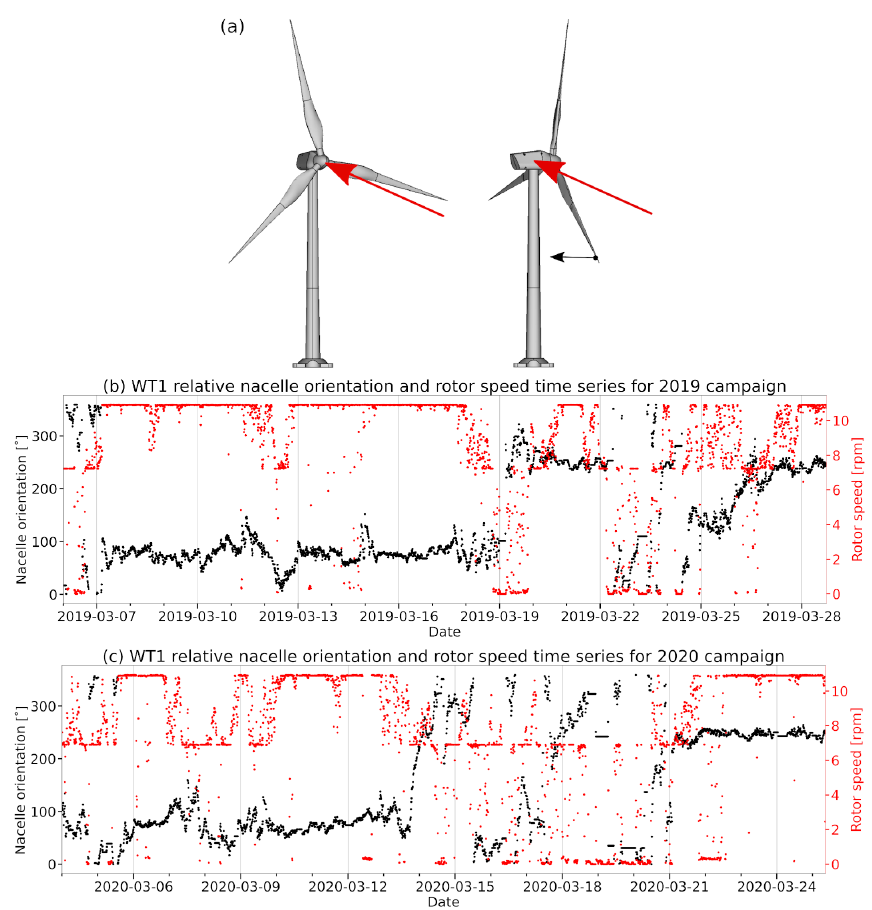
Figure 3. In (a) a schematic view of two wind turbines in relative nacelle positions of 0 ◦ (left) and 270 ◦ (right) with respect to the radar angle of attack (red arrows) is shown. The blade pitch angles are at a high position ( θ > 70 ◦ ), and the direction of blade bending during wind load is indicated by the black arrow. The plots (b) and (c) show the time series of relative orientations (black), with respect to the radar location, of the WT1 nacelle from 6 to 28 March 2019 and from 4 to 25 March 2020. On top and specified by a secondary y axis, the associated rotor speeds are presented in red, in revolutions per minute (rpm). For the measurement campaign in 2019 the time series plot is representatively shown for wind turbine WT1. The offset angle between relative and absolute nacelle orientations is 158 . 9 ◦